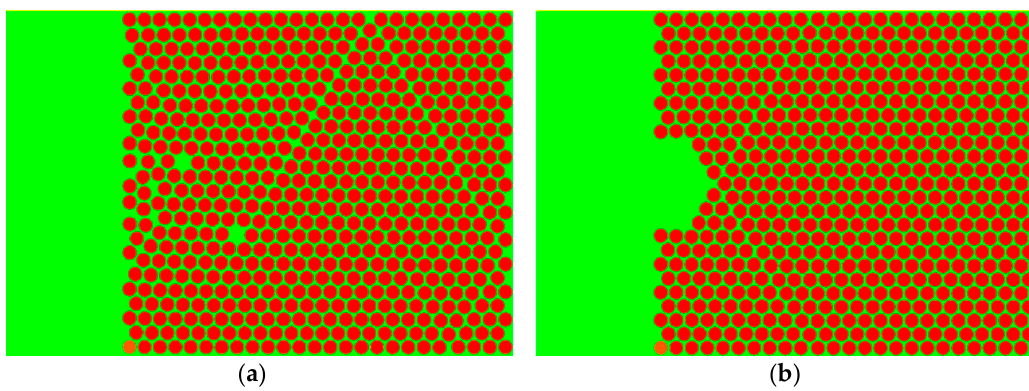
Figure 12. The state of cemented granular media with different bond strengths under the same effective stress and flow erosion: ( a ) continuous sand production for low bonding strength 0.0078 N; and ( b ) the stable cavity for high bonding strength 0.078 N.